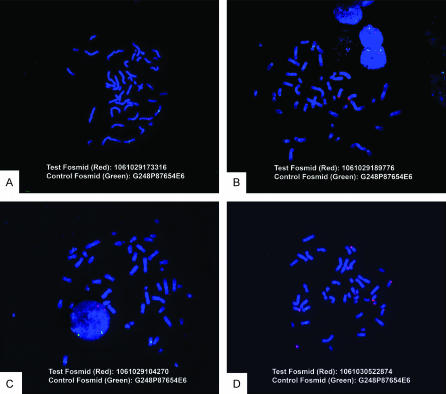
Non-Mapped HuRef Sequences Mapped to Coriell DNA Samples by FISHSequences from the HuRef donor that had no match based on the one-to-one mapping or BLAST when compared to the NCBI Human reference genome were tested by FISH. Fosmids were used as probes and the experiments were run, using Coriell DNA, to confirm the localization of the contigs or to map contigs with no prior mapping information. Shown here are four representative results. (A) An insertion at 7q22 where the FISH confirmed the HuRef mapping, (B) FISH result confirming the mapping of a sequence extending into a gap at 1p21. (C) Localization of a contig with no prior mapping information to chromosomal band 1q42. (D) An example of euchromatic-like sequence with no prior mapping information, which hybridizes to multiple centromeric locations.